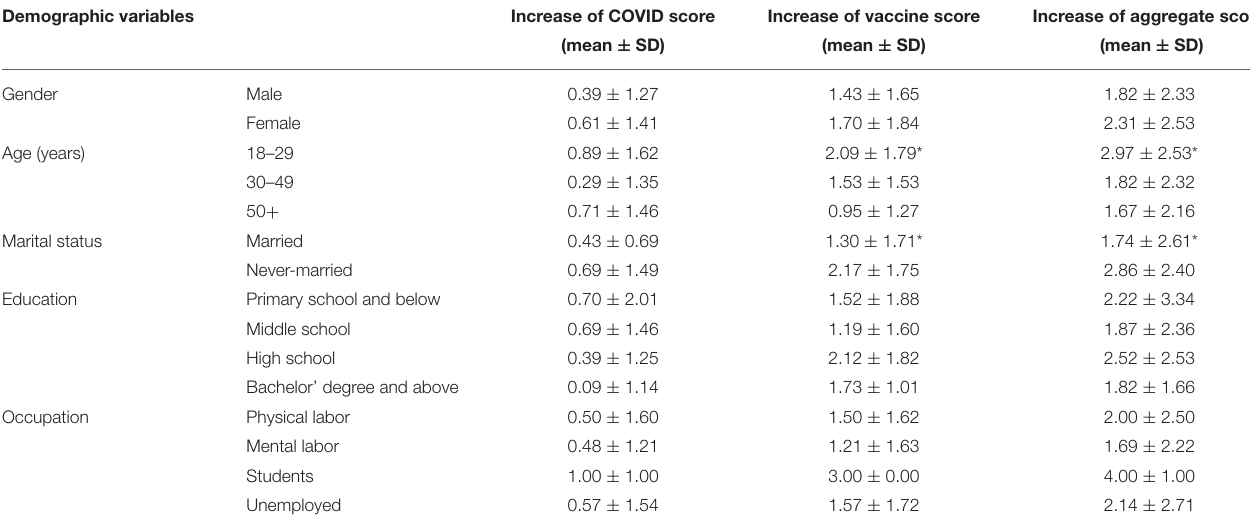
TABLE 3 | Increase of knowledge score by demographic variables. Demographic